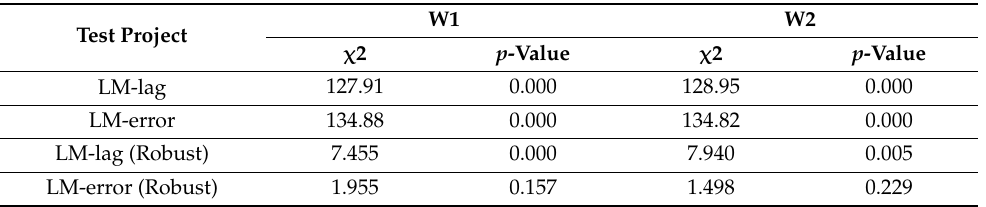
Table 2. LM test of spatial panel model.